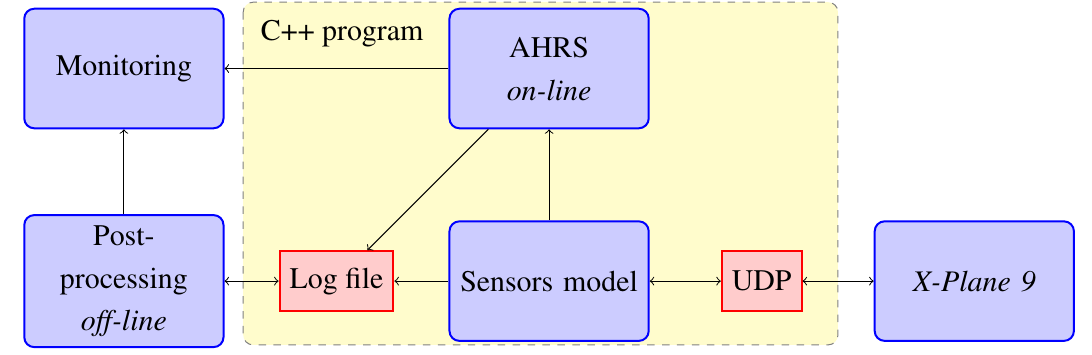
Figure 4. Block diagram of the simulation